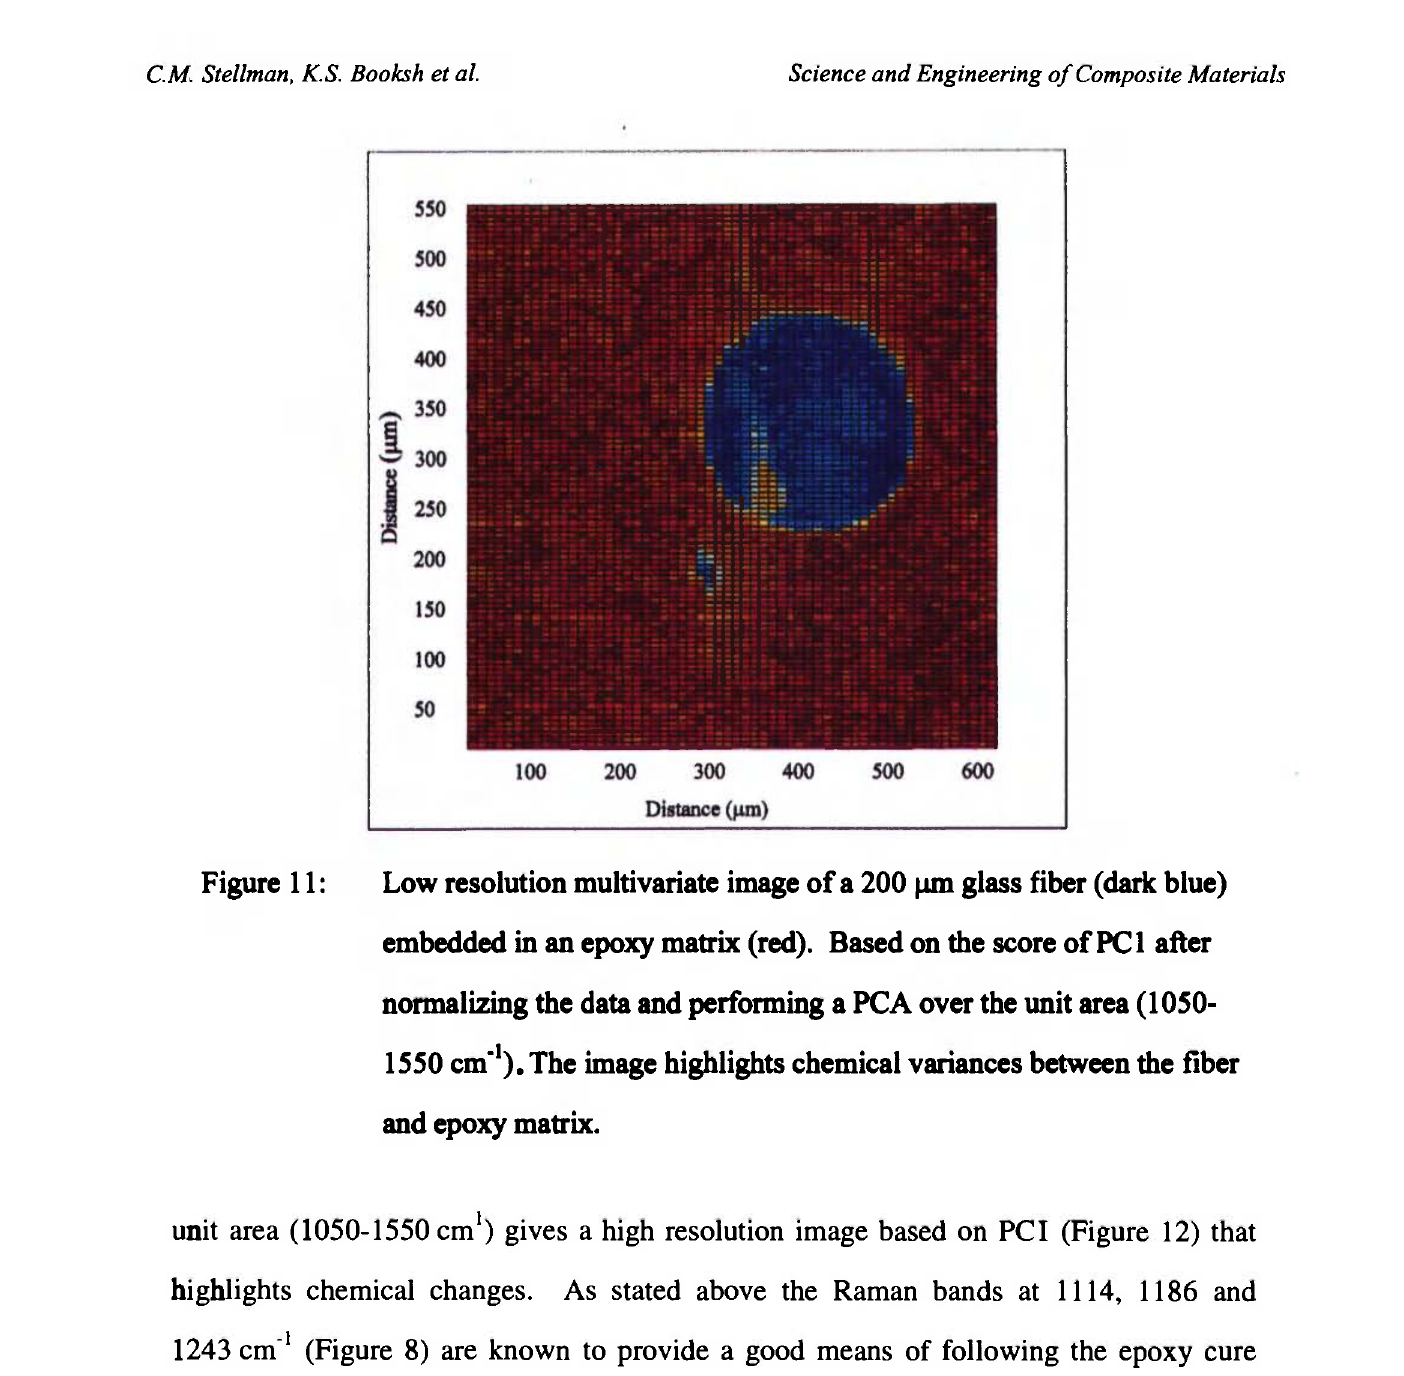
Figure 11: Low resolution multivariate image of a 200 μιη glass fiber (dark blue) embedded in an epoxy matrix (red). Based on the score of PCI after normalizing the data and performing a PCA over the unit area (1050- 1550 cm' 1 ). The image highlights chemical variances between the fiber and epoxy